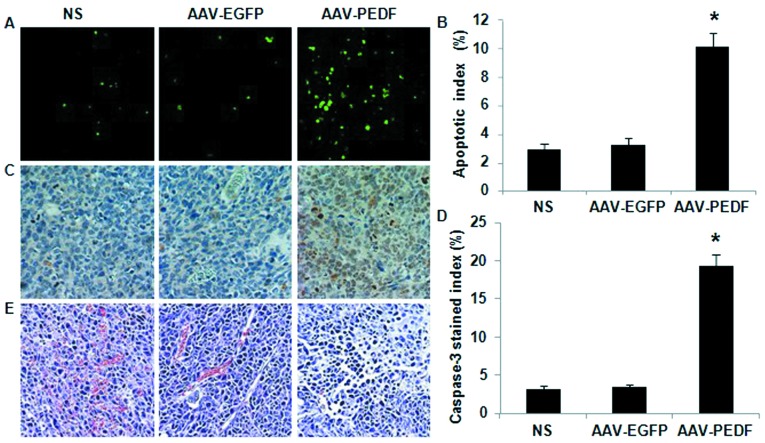
TUNEL, caspase-3 immunohistochemical assay, and histological staining for tumour tissue. (A) Apoptotic cells within LLC tumours were detected by the TUNEL assay (original magnification, ×400). (B) The apoptotic index (%) of LLC tumours treated with NS, AAV-EGFP, and AAV-PEDF (*P<0.05). (C) Micrographs show tumour tissue sections stained with anti-caspase-3 antibody (original magnification, ×400) after NS, AAV-EGFP or AAV-PEDF treatment. (D) The caspase-3 stained index (%) of tumours treated with NS, AAV-EGFP, and AAV-PEDF (*P<0.05). (E) LLC tumours from NS, AAV-EGFP, and AAV-PEDF treated mice were stained with H&E (original magnification, ×400); noticeable necrosis was observed in tumours from AAV-PEDF treated mice.